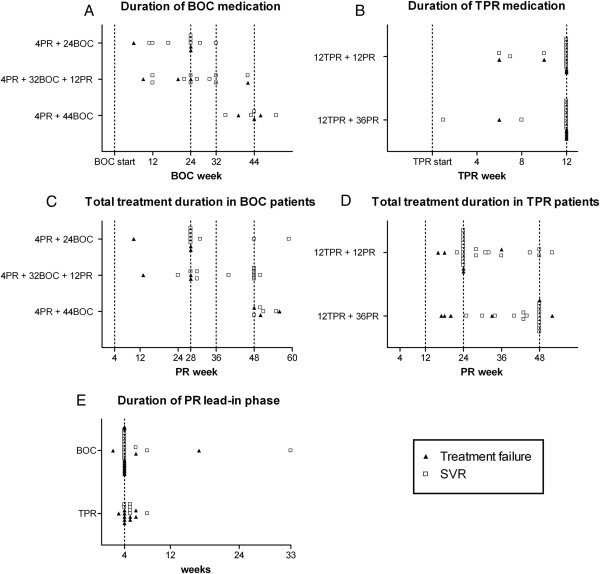
Individualized courses of treatment in our “real-life” cohort. Patients are grouped according to the respective guidelines [14,15]. Each symbol represents one patient. Patients with partial response or breakthrough under BOC/TPR are not depicted in A and B, patients with partial response or breakthrough at any time are not depicted in C and D. All BOC patients and TPR patients who received a dual lead-in phase prior to BOC/TPR are included in E. [BOC = boceprevir; TPR = telaprevir; PR = pegylated interferon and ribavirin; SVR = sustained virological response; EOT = patient concluded therapy, but is short of 12 weeks after last ribavirin dose].